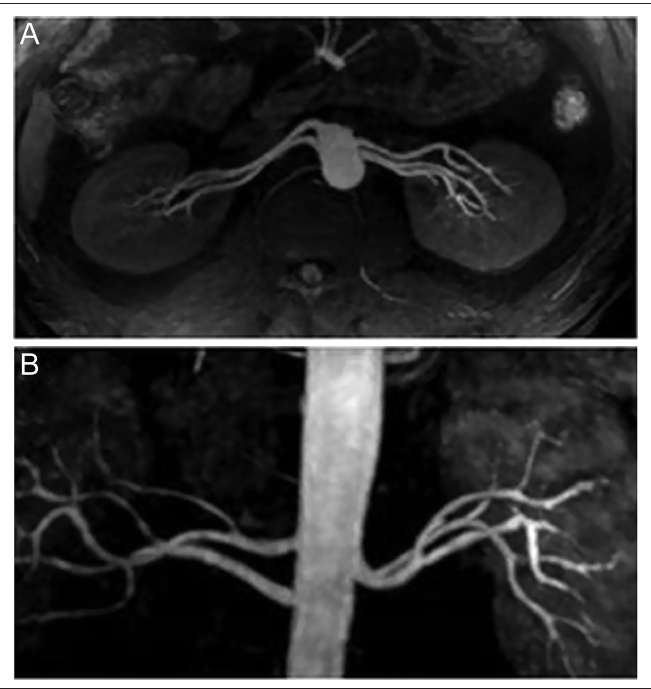
Figure 5. Axial and coronal reformatted MIP images of Inhance sequence for a 49-year-old male patient. Accessory renal artery (bilateral double renal artery) variation.